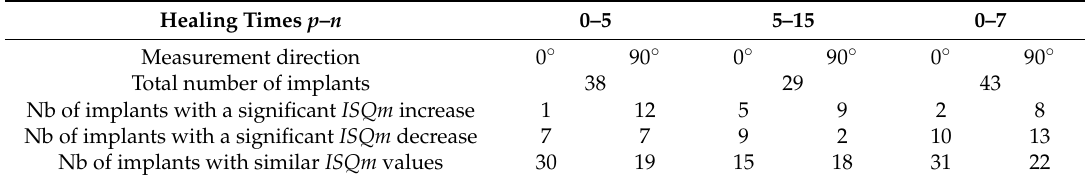
Table 3. Comparison of the results obtained for the variation of ISQ values between different healing times for the two direction of measurement (0 ◦ and 90 ◦ ). The number of implants for which significant increase and decrease of ISQ was indicated, as well as the number of implants for which no significant difference was obtained for the two healing times considered.